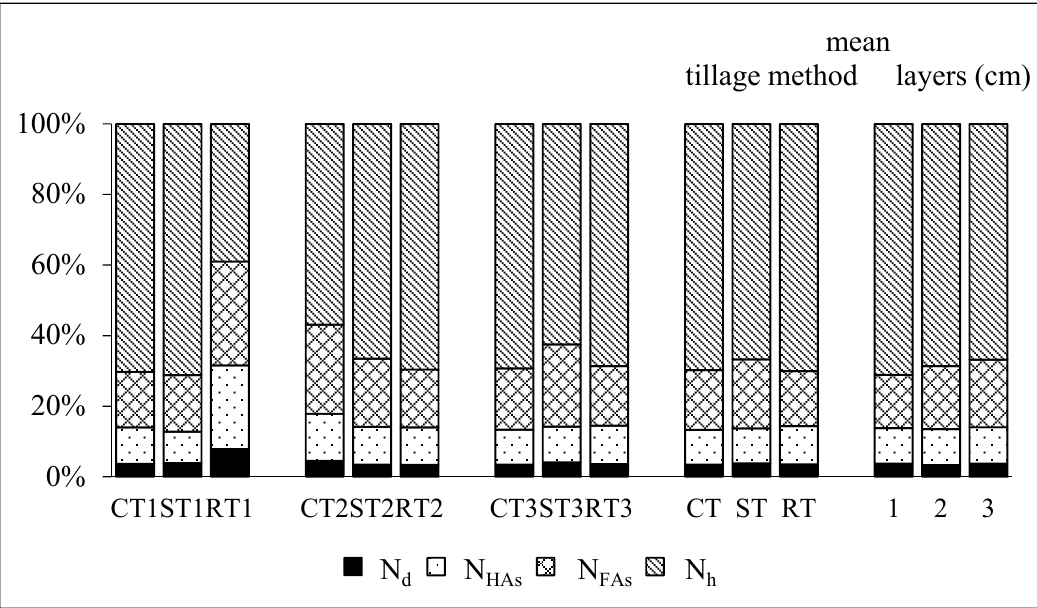
Figure 4. Share of nitrogen in organic matter fraction and average values for factors (LSD for: N d —factor I, n.s. and factor II, 0.24; interaction—I/II, n.s. and II/I, n.s.; N HAs —factor I, n.s. and factor II, n.s; interaction—I/II, 1.86 and II/I, 0.87; N FAs —factor I, 0.47 and factor II, 1.08; interaction—I/II, 1.87 and II/I, 1,59; N h —factor I, 1.48 and factor II, 1.56; interaction—I/II, 2.57 and II/I, 2.21.